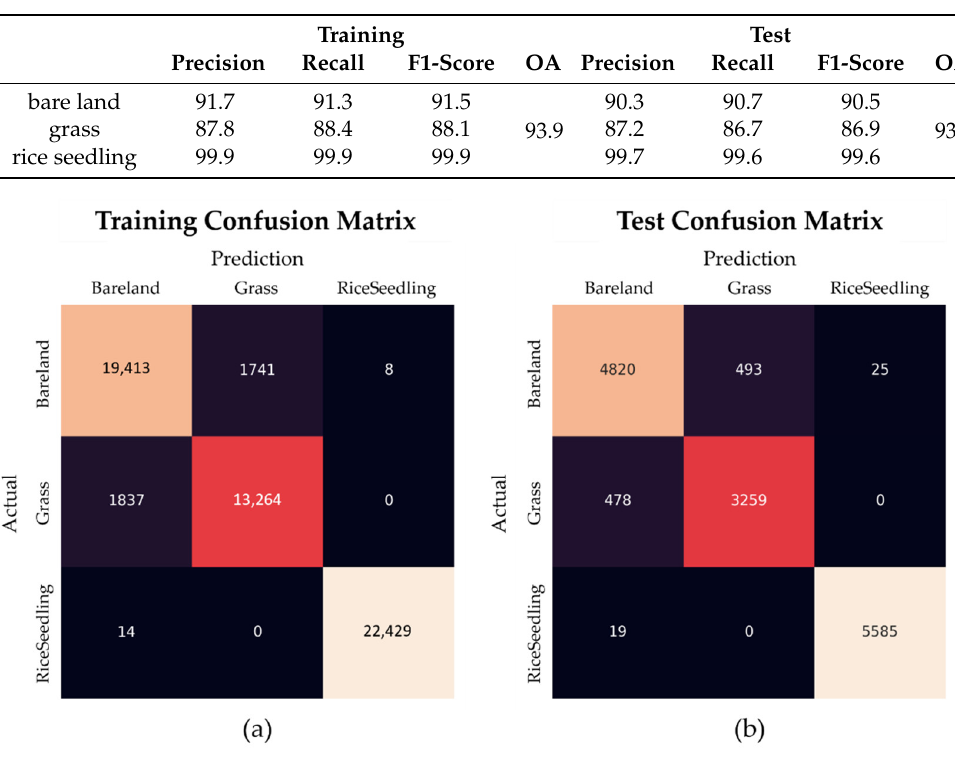
to keep the positive pixels. Finally, the process of finding contours is applied to identify every closed object and to generate the bounding boxes.